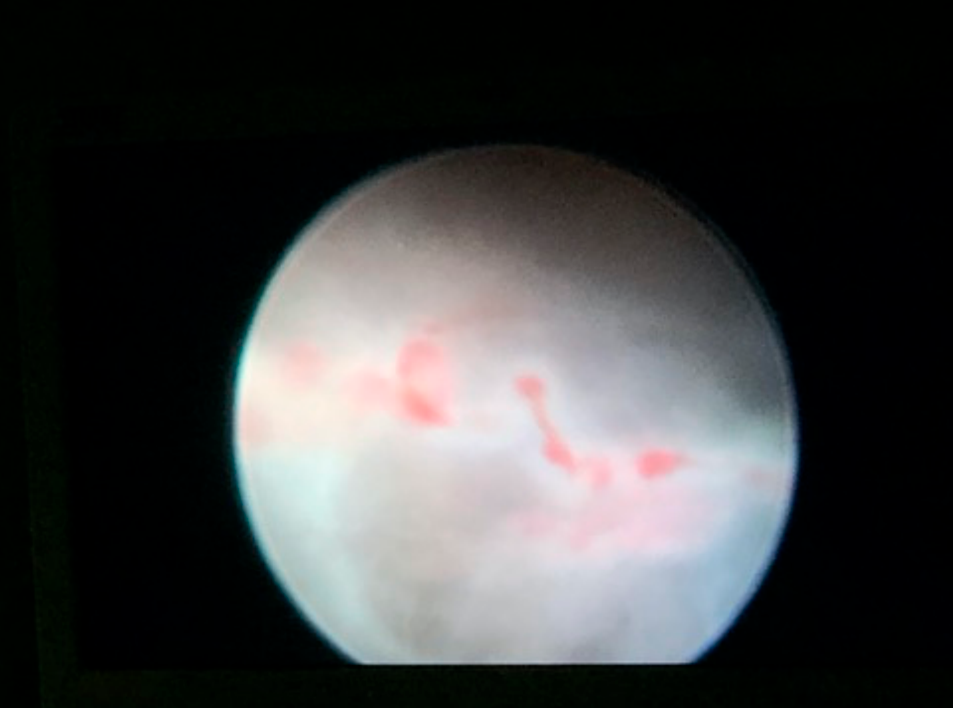
Figure 2. Hysteroscopic view of the umbilical cord and the gestational sac.